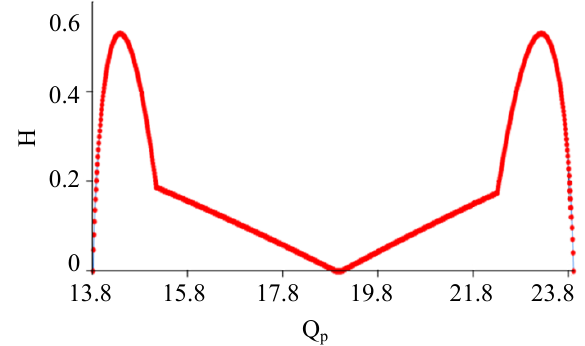
Fig. 6. Graph of fuzzy material entropy of the